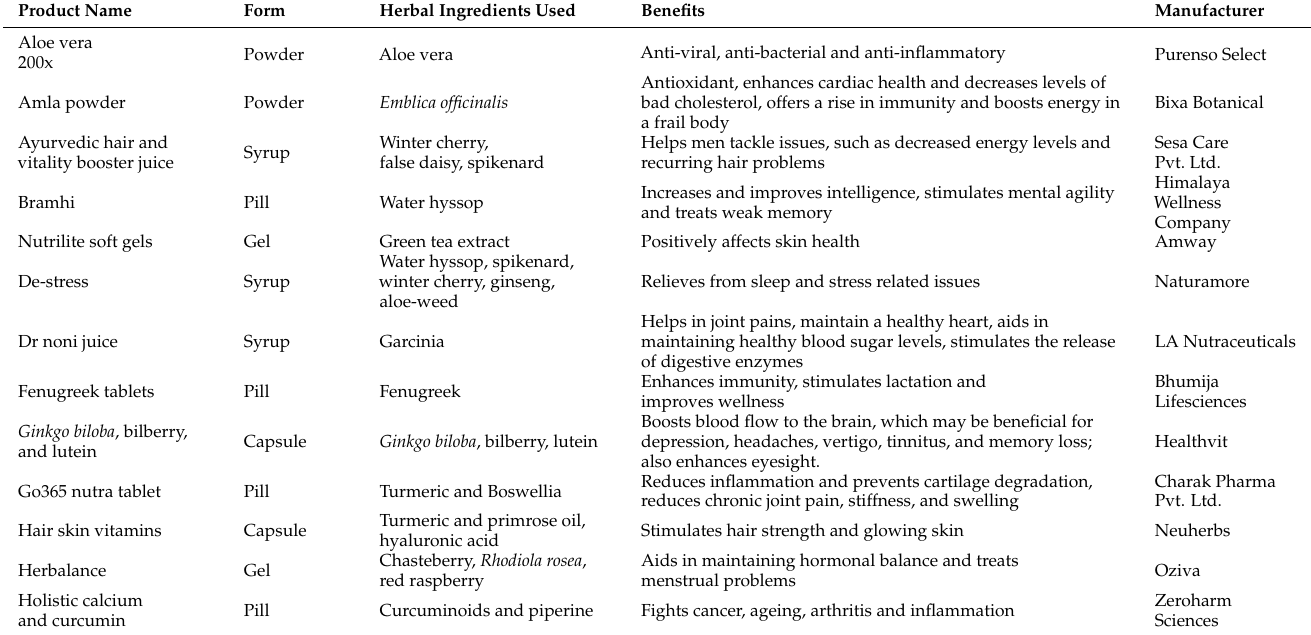
Table 2. Various formulations of commercially available nutraceuticals and their